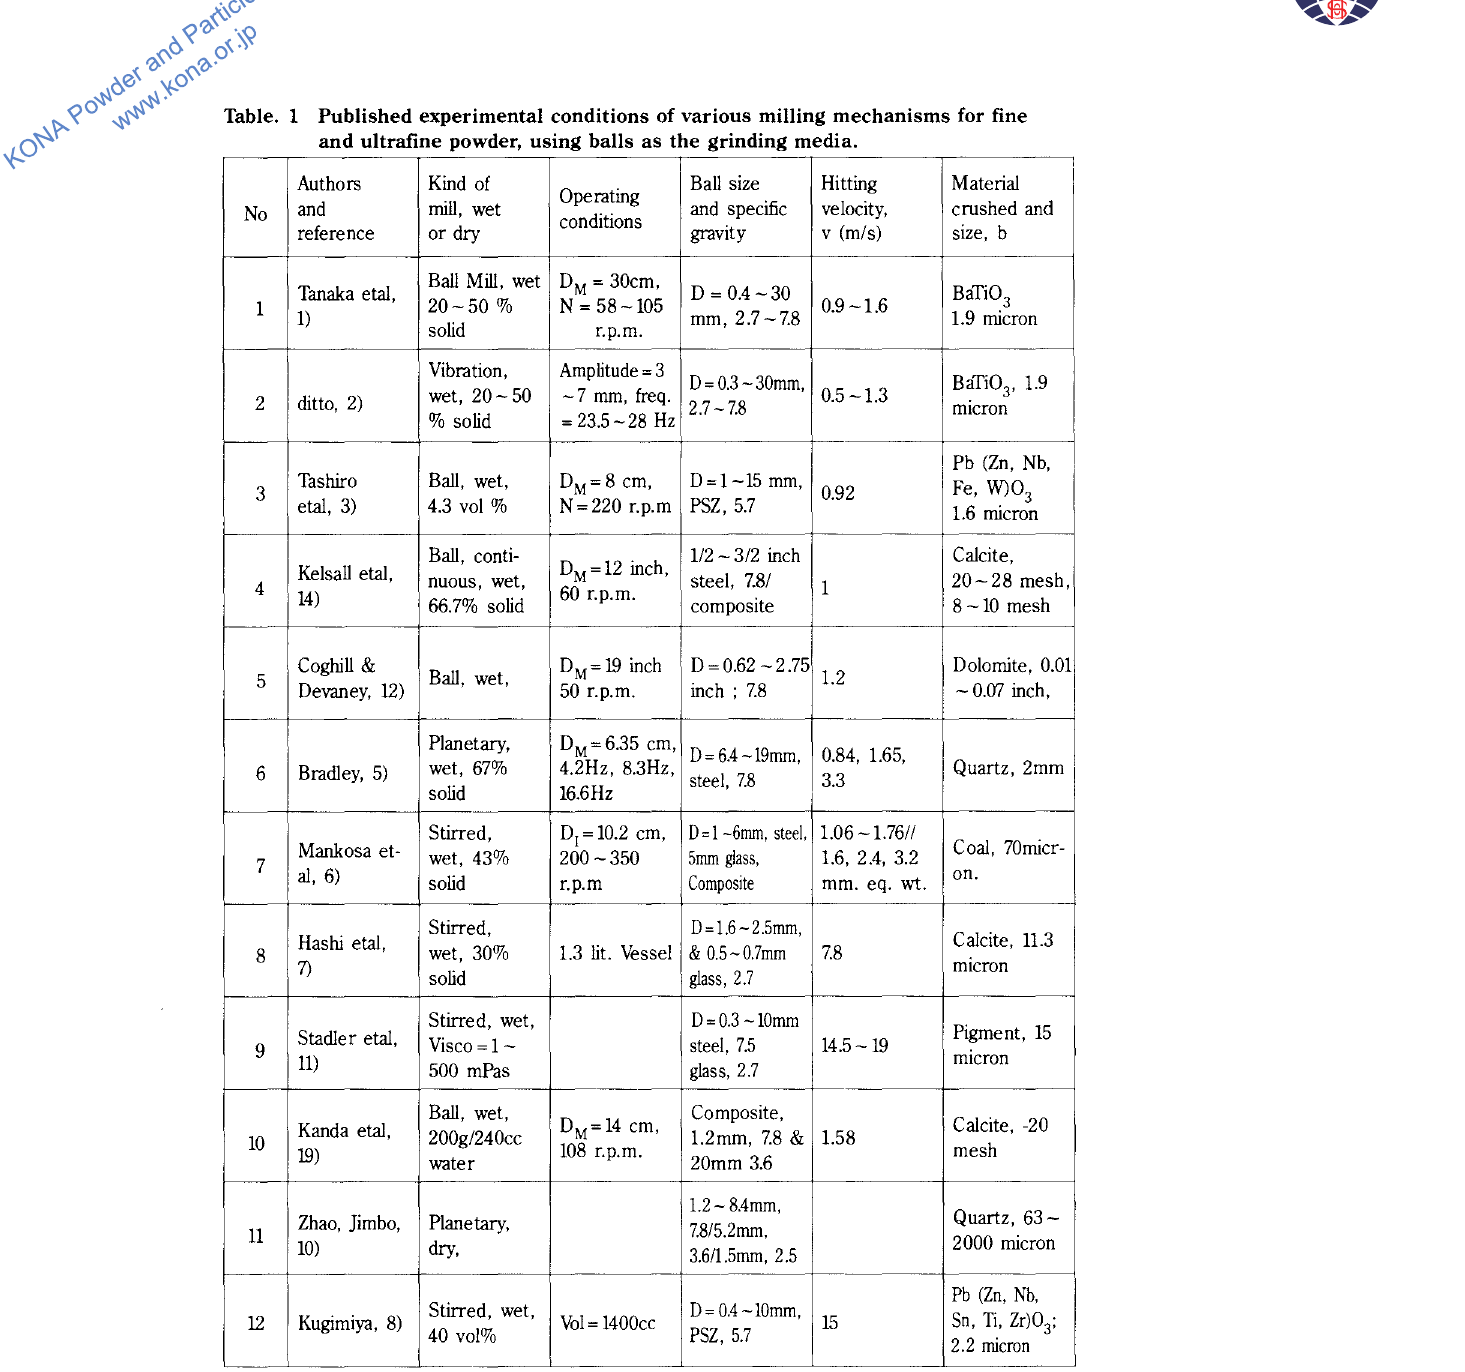
Table. 1 Published experimental conditions of various milling mechanisms for fine and ultrafine powder, using balls as the grinding media. Ball size Hitting Material and specific velocity, crushed and